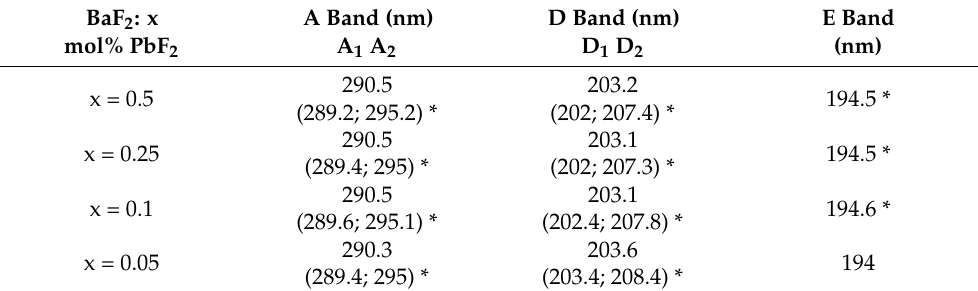
Figure 5. ( a ) Gaussian multi-peak fitting of the A band for two samples; ( b ) variation of intensity of the A band (290 nm) and of the components A 1 and A 2 (see the inset) on the PbF 2 concentration. Table 2. Maxima of the optical absorption bands of BaF 2 : x mol% PbF 2 crystals as a result of the absorption spectra and by Gaussian multi-peak fitting *.